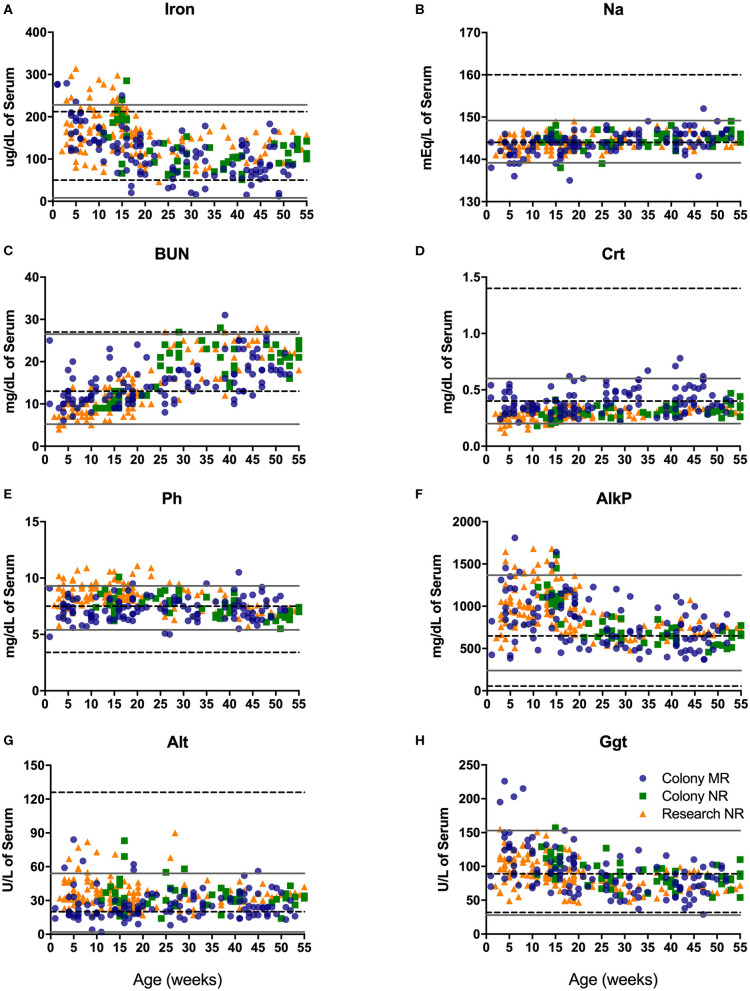
Clinical reference ranges (calculated as ±2 st. dev. values from the mean) for select serum chemistry parameters illustrate differences between pediatric <1yr old (gray solid lines) and adult (dotted black lines) rhesus macaques. Data points were plotted at age of sampling from Colony MR animals (blue circles), Colony NR animals (green squares), and Research NR animals (orange triangles). Parameters analyzed consisted of iron (A), sodium or Na (B), blood urea nitrogen or BUN (C), creatinine or Crt (D), phosphorus or Ph (E) alkaline phosphatase or AlkP (F), alanine aminotransferase or Alt (G), and gamma glutamyl transferase or Ggt (H).